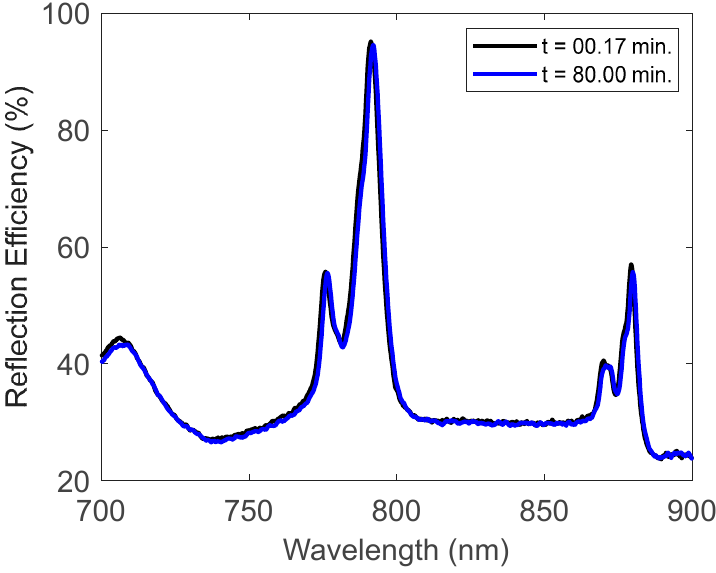
Figure 7. Experimentally measured reflection spectrum during sensor incubation in a Con A and PBS solution (1 mg/mL). The spectra displayed are at beginning incubation time 0.17 min and at final incubation time 80.00 min.